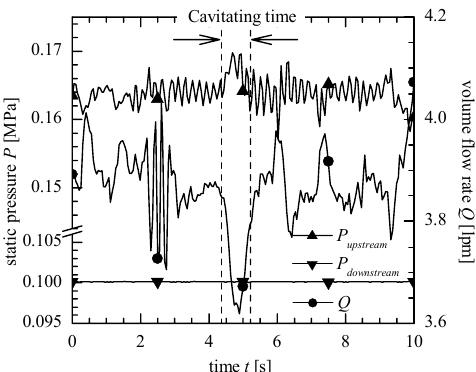
Fig. 7 Time evolution of the volumetric flow rate and the static pressure upstream and downstream of the nozzle in the intermittent cavitation type ( T = 73.9 K, Q = 3.91 lpm, σ =